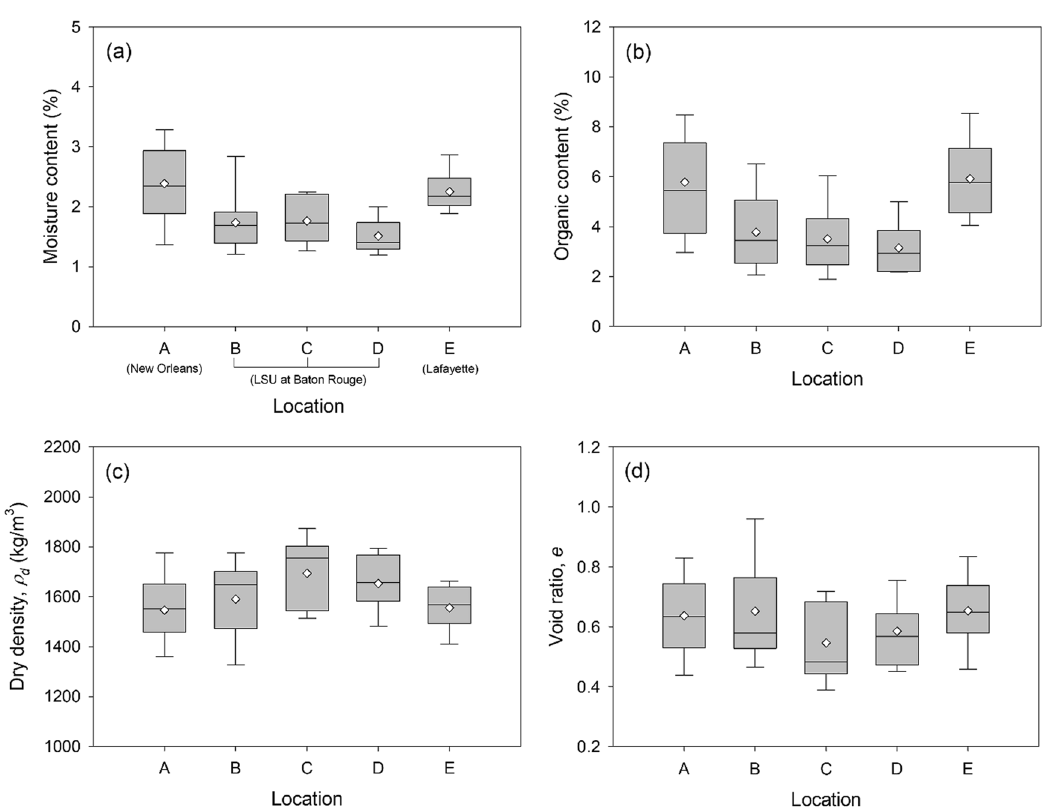
Figure 4. Comparisons of the physical properties of the nest samples by locations: ( a ) moisture content, ( b ) organic content, ( c ) dry density, and ( d ) void ratio. Horizontal lines extending from the boxes through the whiskers indicate the minimum and maximum values. Horizontal edges of the boxes indicate the first quartile (Q1) and the third quartile (Q3). The horizontal line in the middle of the box indicates the median. The mean is shown as the diamond